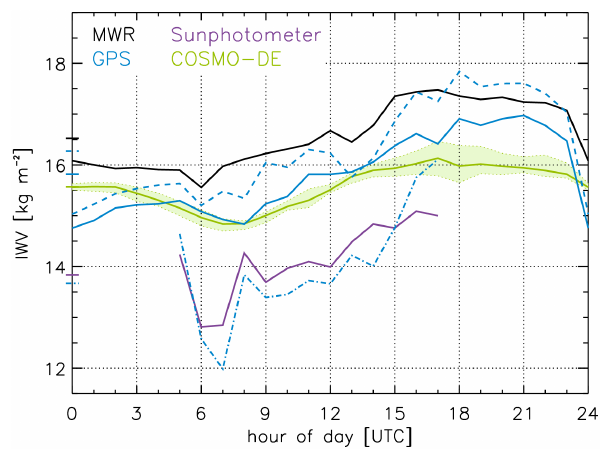
Figure 9. Mean daily cycle of IWV during HOPE measured with MWR with 15min resolution (black), GPS (solid blue), GPS for coincident measurements with MWR (dashed blue), GPS for coin- cident measurements with sun photometer (dash-dotted blue), sun photometer (purple), and simulated with COSMO-DE (green). The shaded green area represents the spread of differently aged forecasts of COSMO-DE. The ticks on the y axis represent the respective 2- month